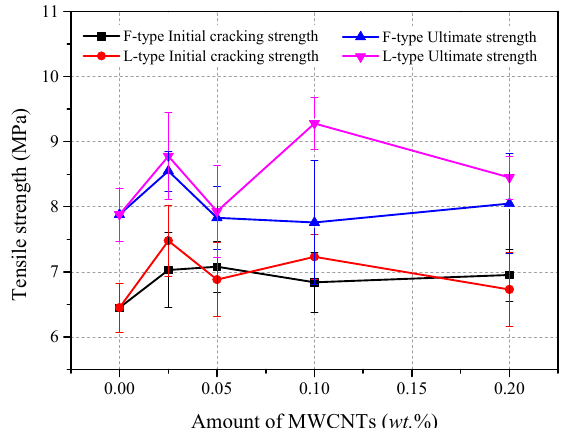
Figure 5. Direct tensile strength of each group.